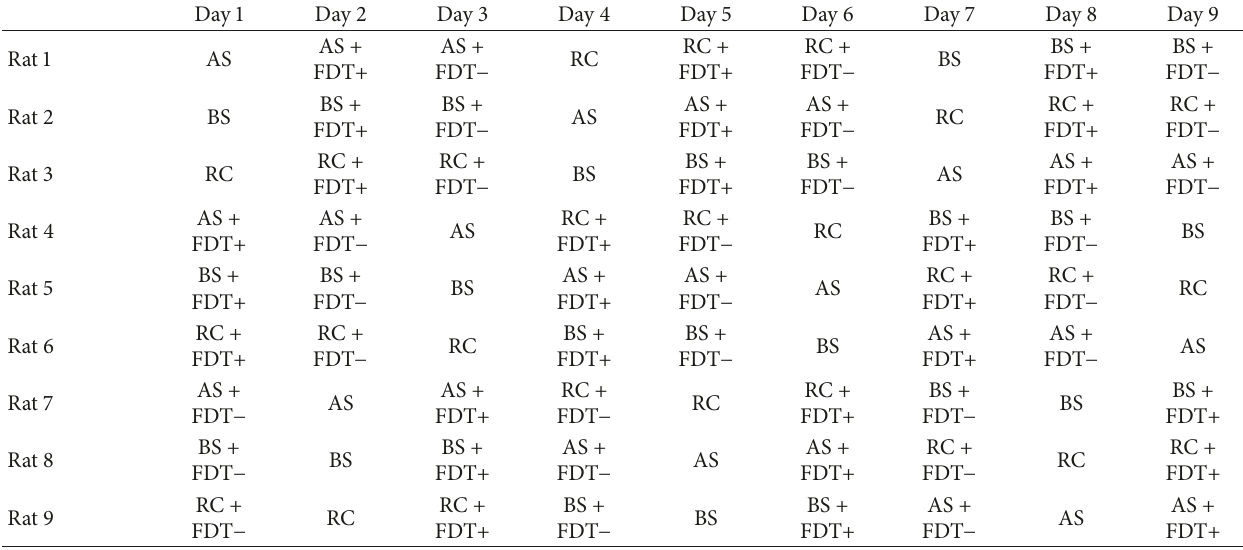
Table 2: Schedule for daily 1-h consumption tests of applesauce (AS), banana sauce (BS), and rice cereal (RC), with placebo FDT − and with